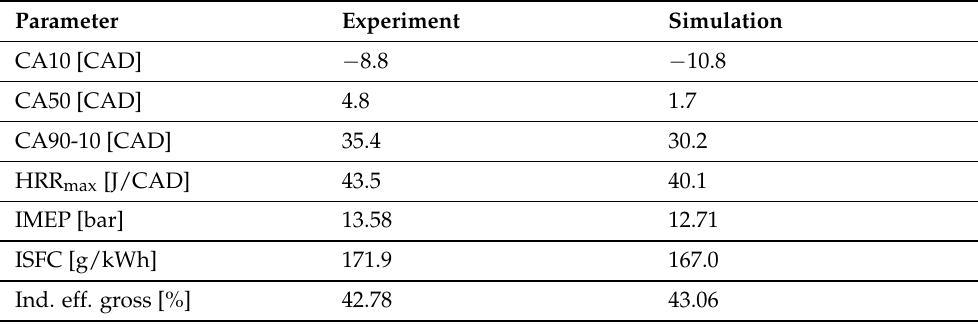
Figure 8. Validation of the virtual engine model coupled with the combustion model. In-cylinder pressure and HRR signals are compared with the results measured in the test bench. Table 4. Validation of the virtual engine model coupled with the combustion model. Combustion- related parameters are included together with other engine